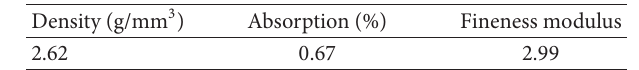
Table 2: Properties of fine aggregate.